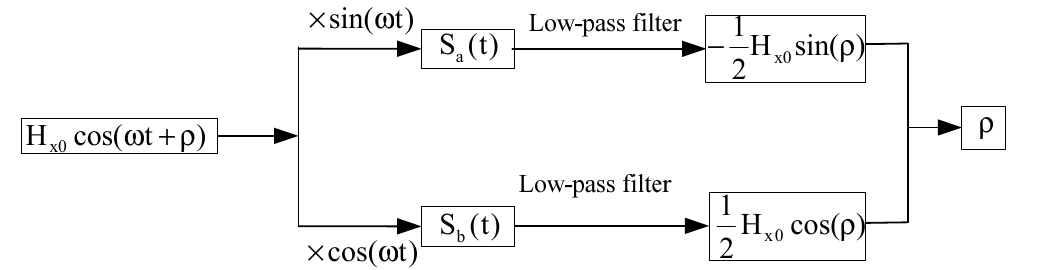
ρ . Figure 1. Specific solution to calculated initial phase ρ